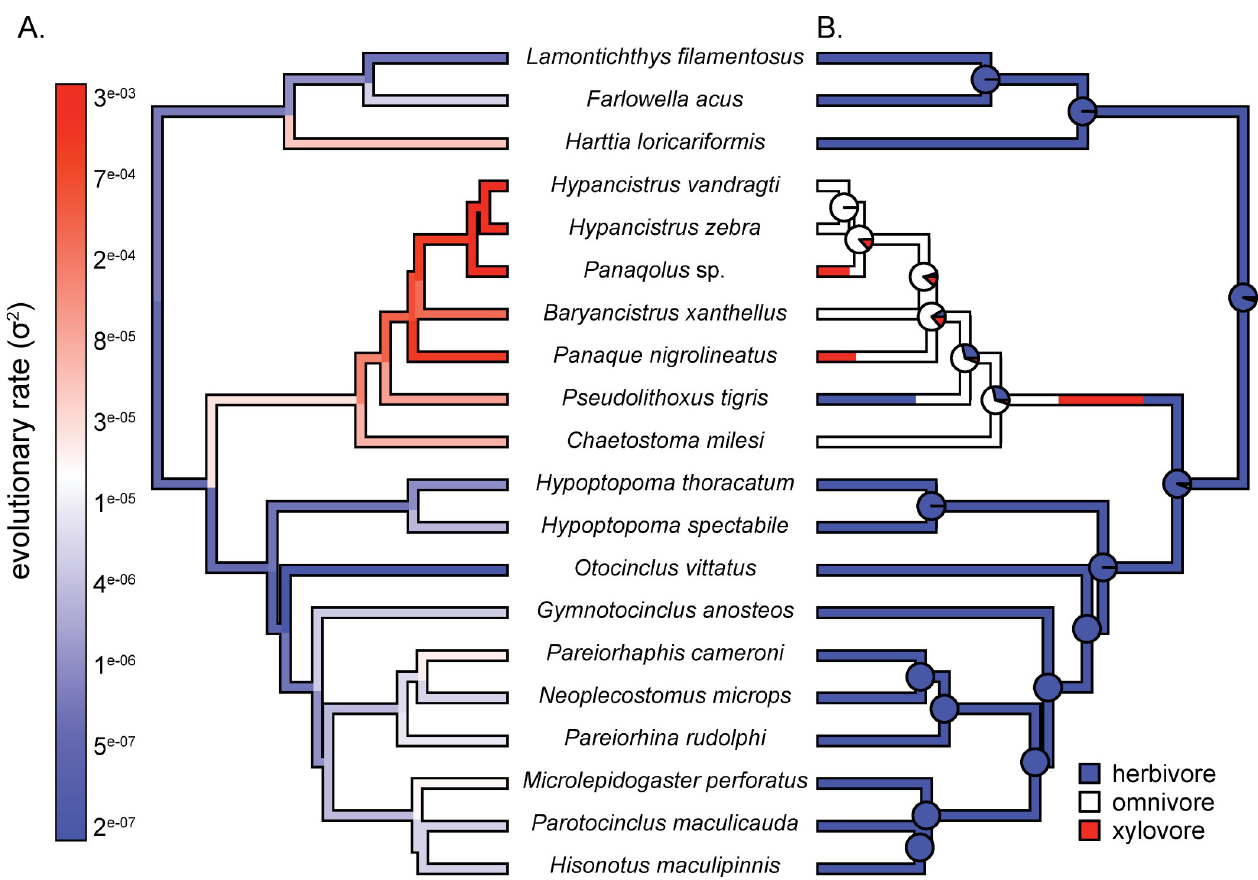
Fig 4. (A) Evolutionary rates for combined dataset of automated landmarks for PC1 using a penalized-likelihood model compared to (B) the ancestral state reconstructions for diet type in loricariid species.